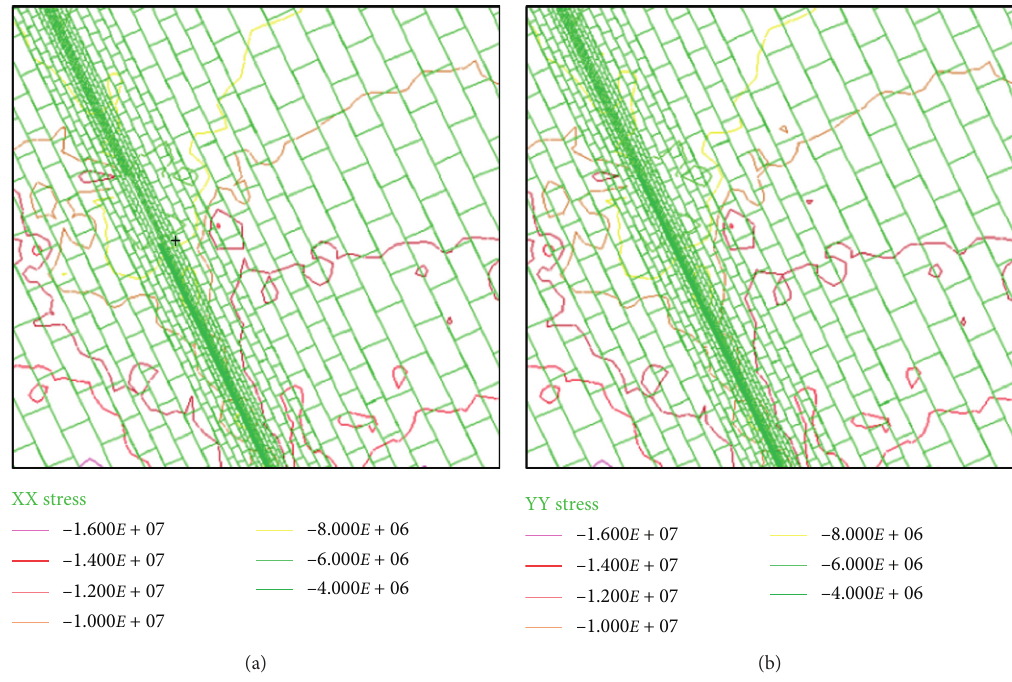
Figure 10: Surrounding rock vertical stress distribution with 40m stope height. (a) Caving. (b)